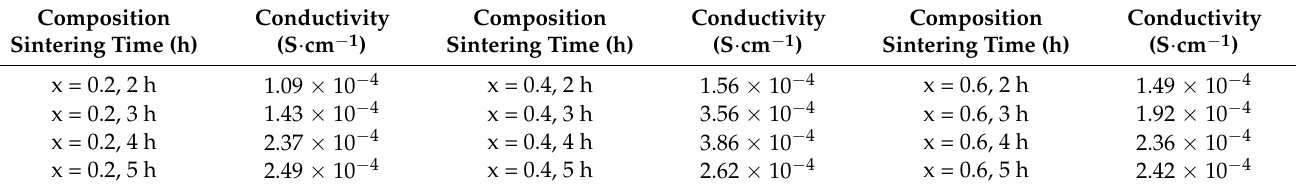
Table 1. Total ionic conductivity of LLZN x O (x = 0, 0.2, 0.4, 0.6) ceramics at different sintering